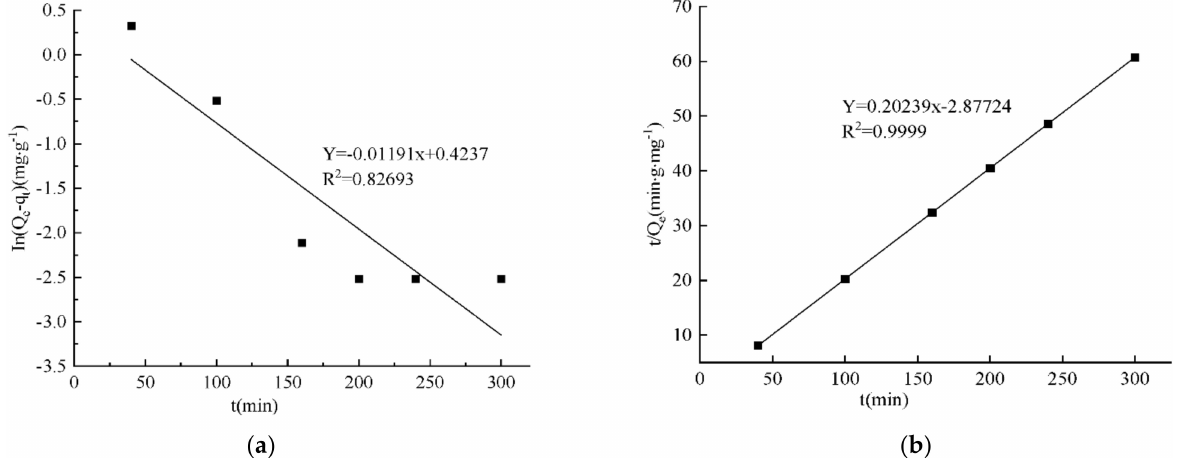
Figure 13. Quasi-first-order kinetic model ( a ) and quasi-second-order kinetic model ( b ). Table 5. Quasi-first-order and quasi-second-order adsorption kinetics fitting parameters. Quasi First Order Dynamics